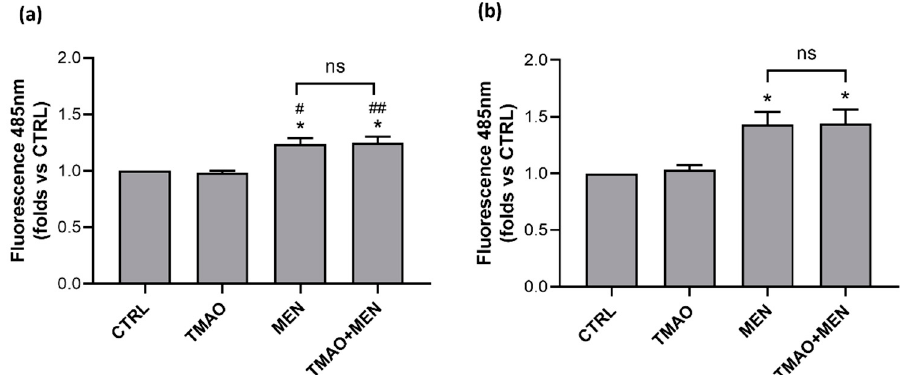
Figure 3. TMAO does not impact reactive oxygen species (ROS) increase. Bar graphs of mean fluorescence (Ex/Em 485 nm/520 nm) related to control condition (CTRL) showing that TMAO 100 µ M was not able to induce ROS production in basal condition and it acted as a neutral factor in presence of a stressor, MEN, after ( a ) 1 h and ( b ) 24 h of treatment (n = 3 independent experiments). * p < 0.05 (vs. CTRL); # p < 0.05, ## p < 0.01 (vs. TMAO).